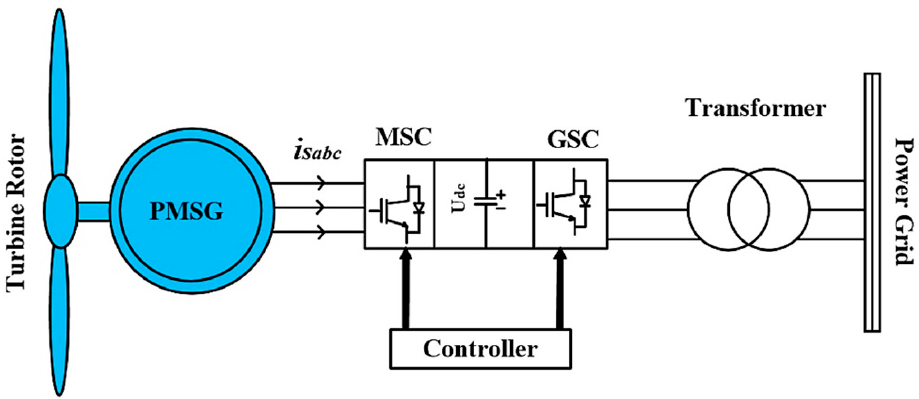
Figure 3 . PMSG-based wind turbine. Figure 3. PMSG-based wind